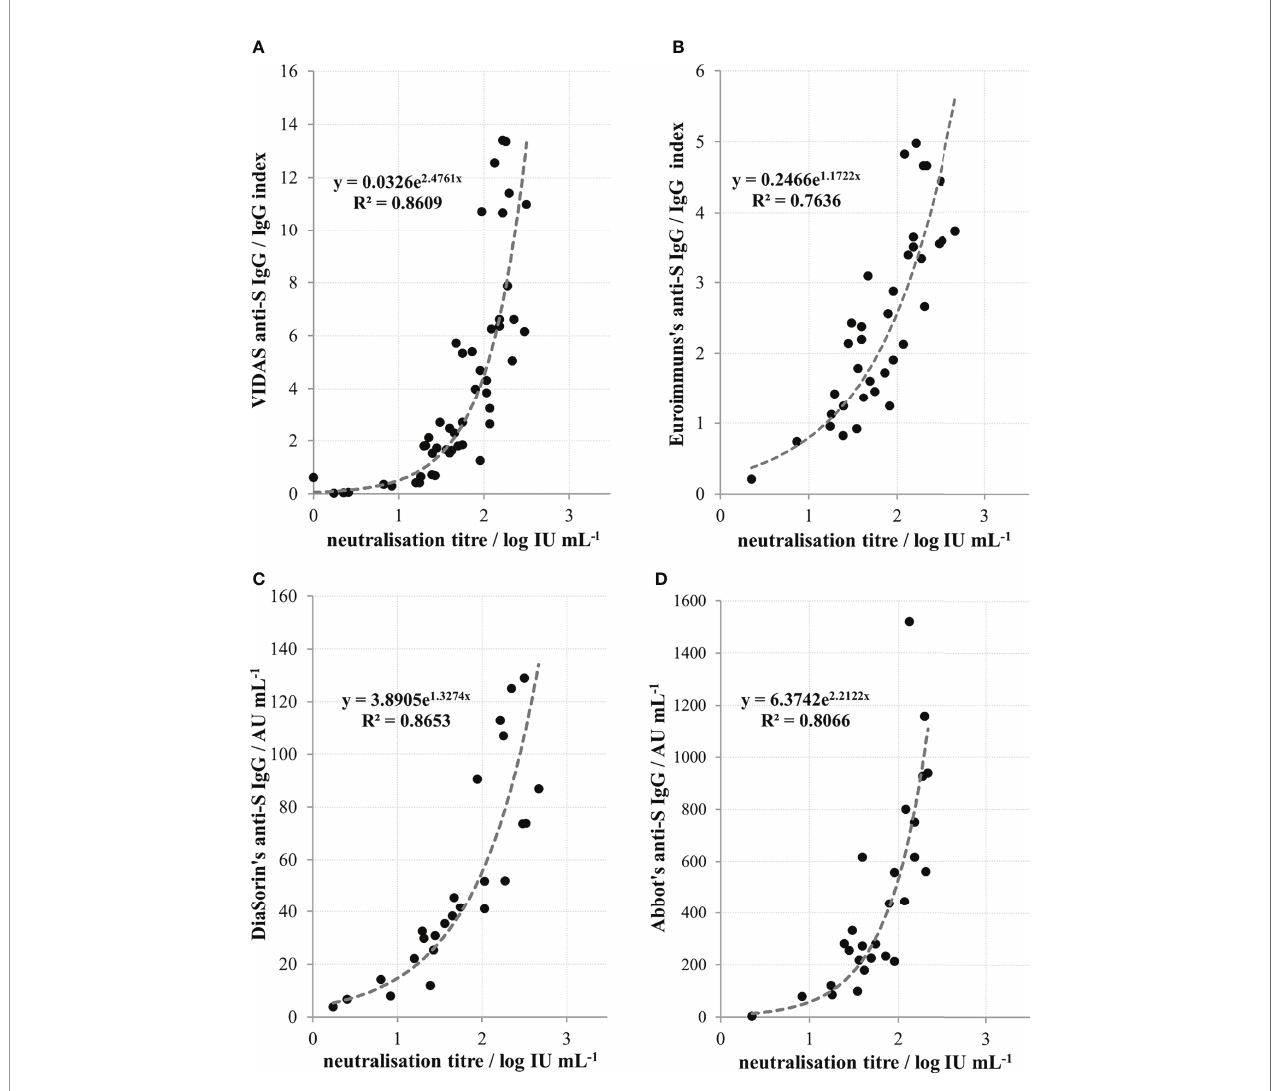
FIGURE 5 | Relationship between neutralisation titres of convalescent sera and quantity of anti-spike protein (anti-S) IgGs determined by (A) Biomerieux ’ s VIDAS ( r =0.93, n =49), (B) Euroimmun ’ s ( r =0.87 ; n =36), (C) DiaSorin ’ s ( r =0.93; n =25) and (D) Abbott ’ s ( r =0.90; n =27) commercial assays. Coef fi cient r denotes Pearson ’ s coef fi cient of correlation from the n number of